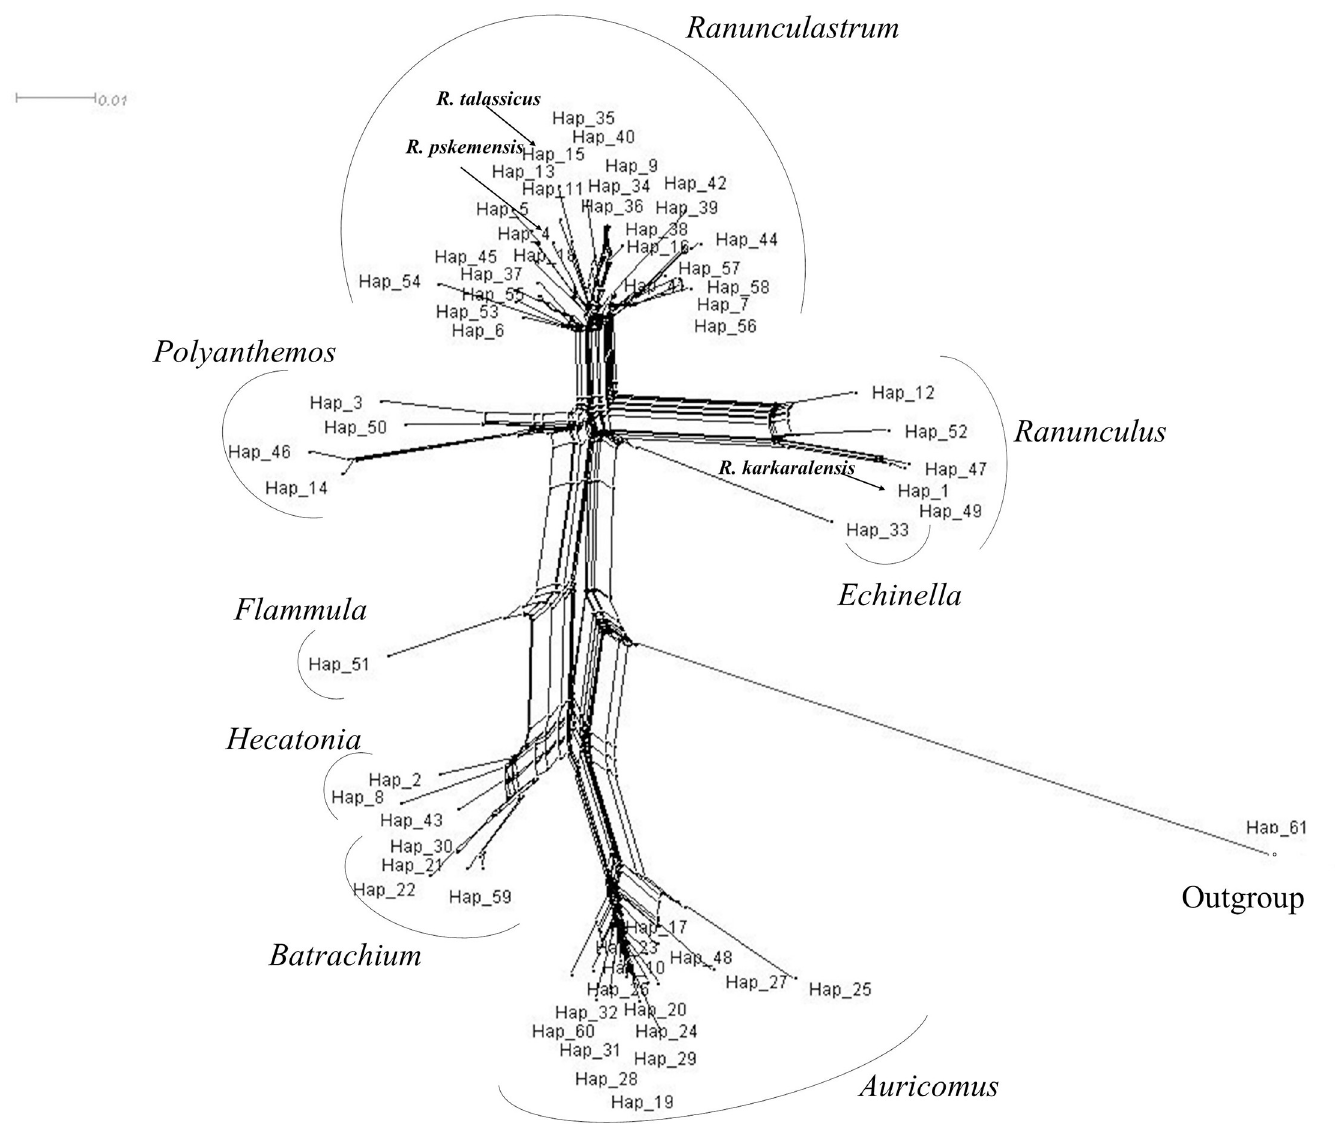
Fig 4. Neighbor-Net graph based on Ranunculus ITS